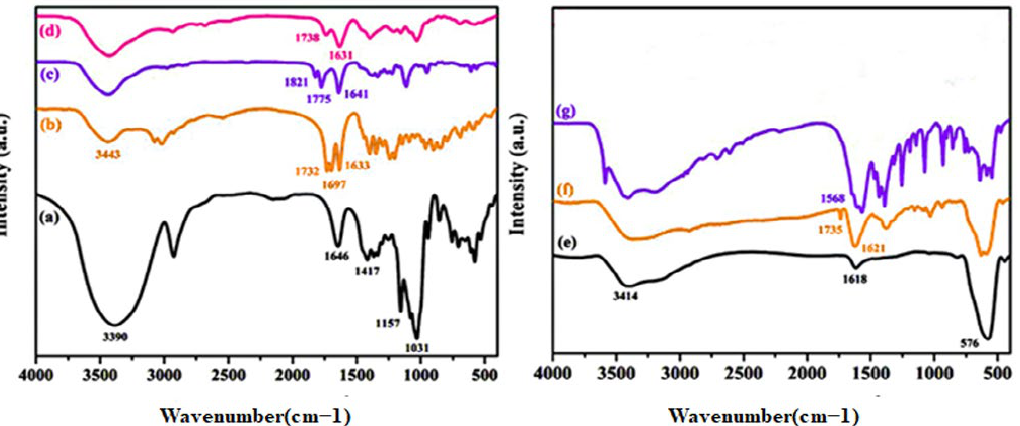
Figure 1. FTIR analysis of the synthesized magnetite/Gd 3+ /β - cyclodextrin nanoplatform. FT-IR spectra of βCD ( a ), DTPA ( b ), DTPA - DA ( c ), PCD ( d ), Fe 3 O 4 ( e ), Fe 3 O 4 @PCD ( f ), and Fe 3 O 4 @PCD - Gd ( g ).